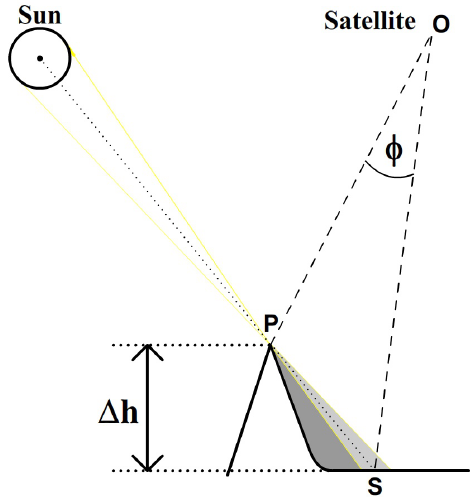
Figure 2. Schematic geometry of height difference calculations using shadows. The shadow S is cast by the projector P , and it is known to lie on the line (cid:12) – P . We can calculate the 3D position of the shadow ( S ) by using the angular size of the shadow from the satellite φ